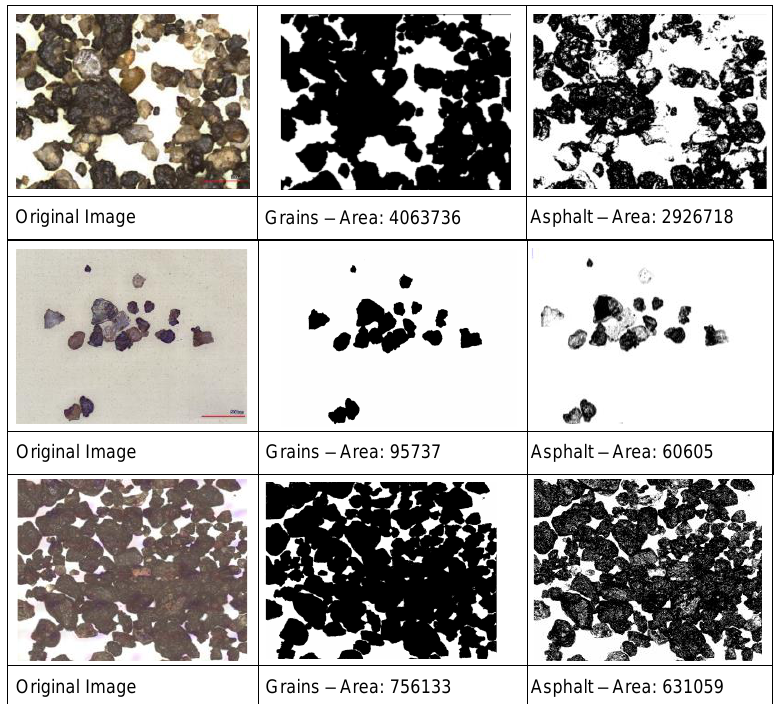
Figure 12. Fine aggregates ( a ) natural ( b ) RAP.